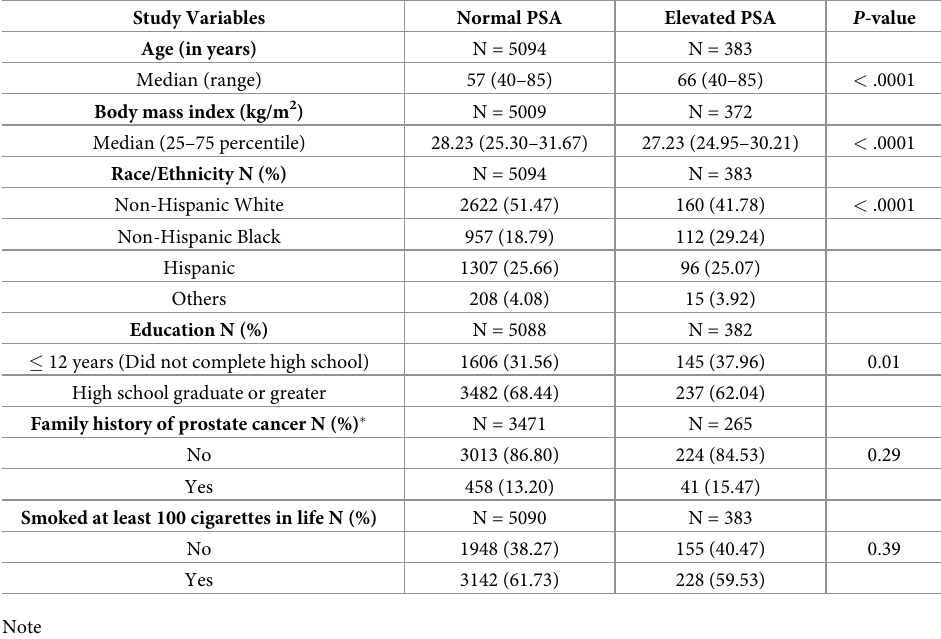
Table 1. Description of 2003–2010 NHANES Men by serum PSA levels.